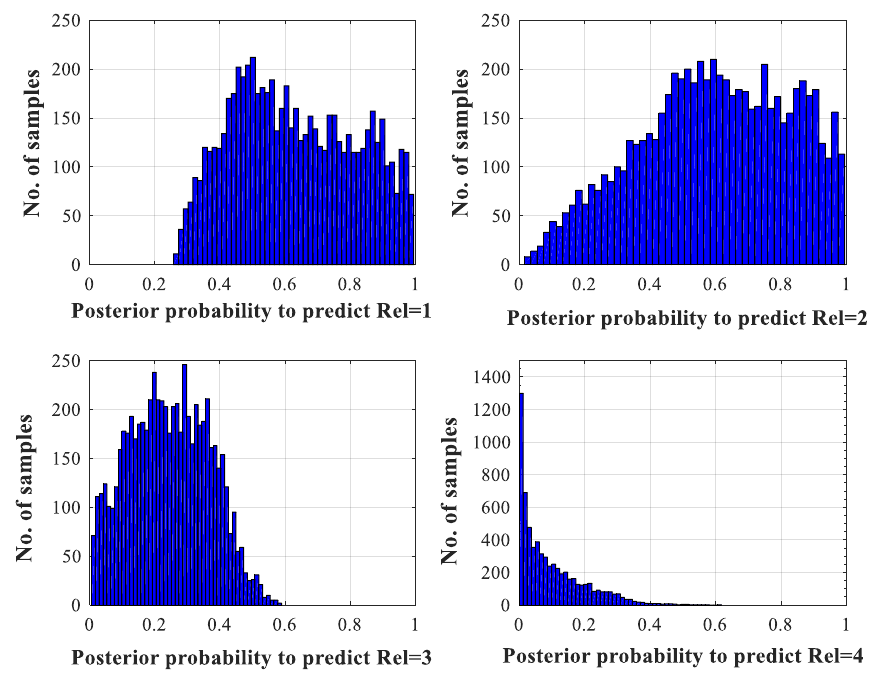
Figure 6. Posterior probabilities corresponding to different predicted reorder levels.